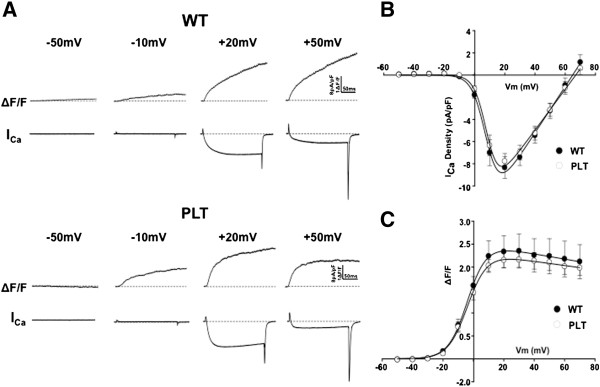
L-currents and voltage-gated Ca2+ release are unaltered in pale tremor ( plt ) myotubes. (A) Representative whole-cell L-type Ca2+ currents (ICa) and intracellular Ca2+ transients (ΔF/F) obtained following 200-ms depolarizations to the indicated membrane potentials in myotubes derived from either wild-type (WT) mice (upper panel) or plt mice (lower panel). (B) and (C) Average (±SEM) voltage dependence of peak L-type Ca2+ current density (B) and intracellular Ca2+ transients (C) for myotubes derived from either WT mice (filled circles) or plt mice (open circles).